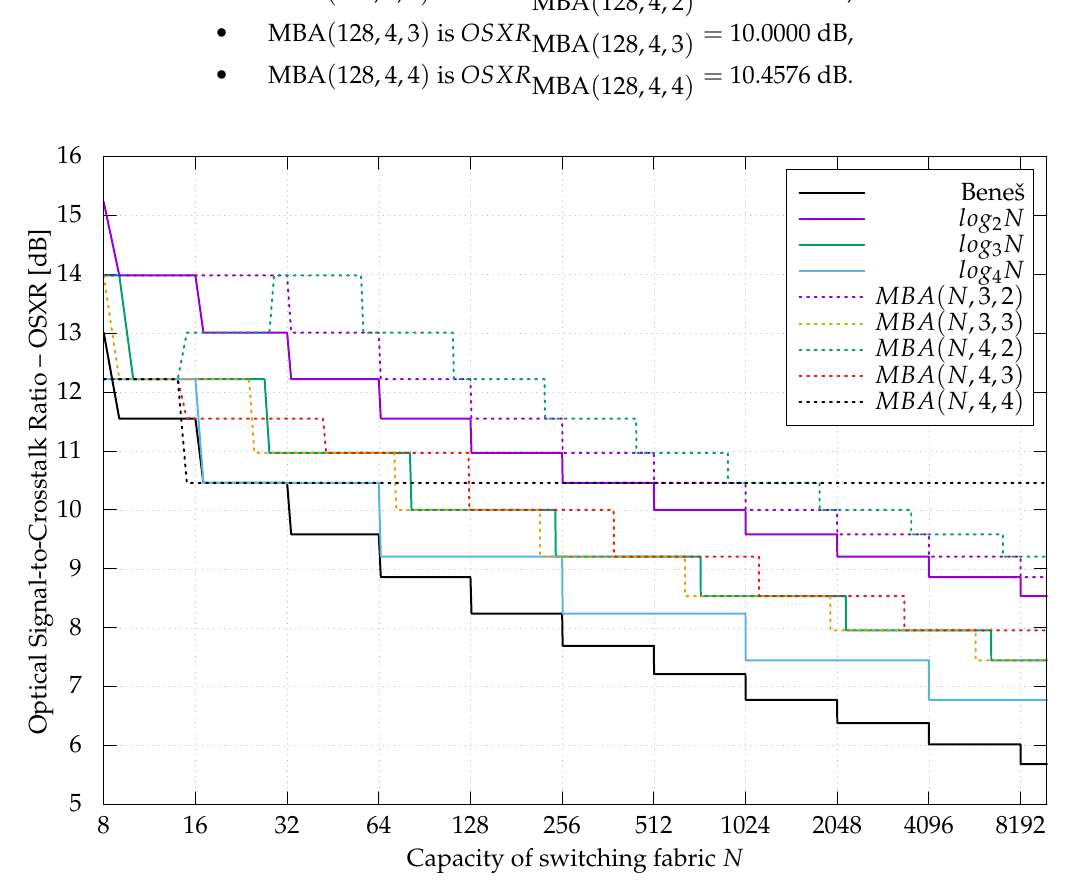
Figure 10. Optical signal-to-crosstalk Ratio (OSXR) for different switching